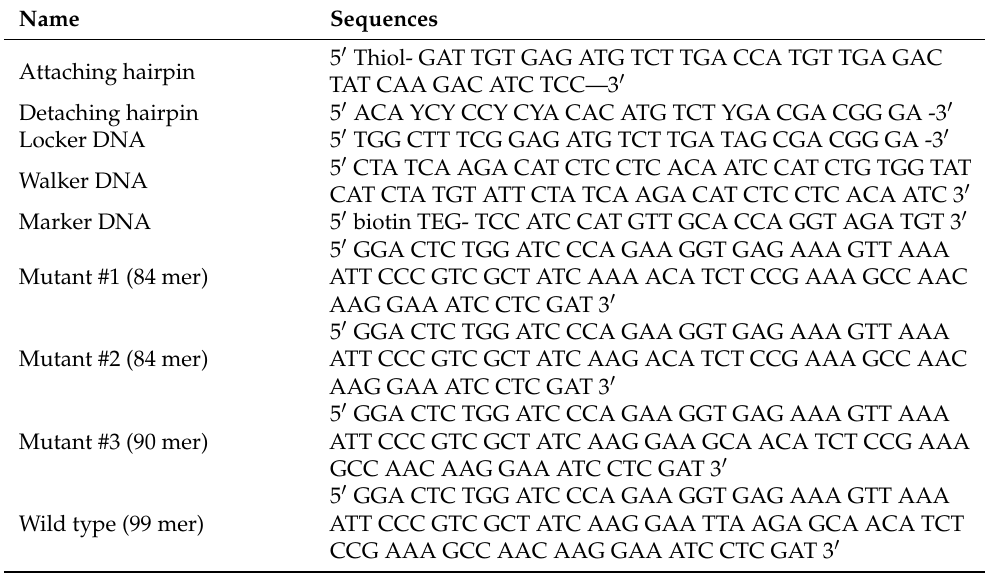
Table 1. The oligonucleotides used in this